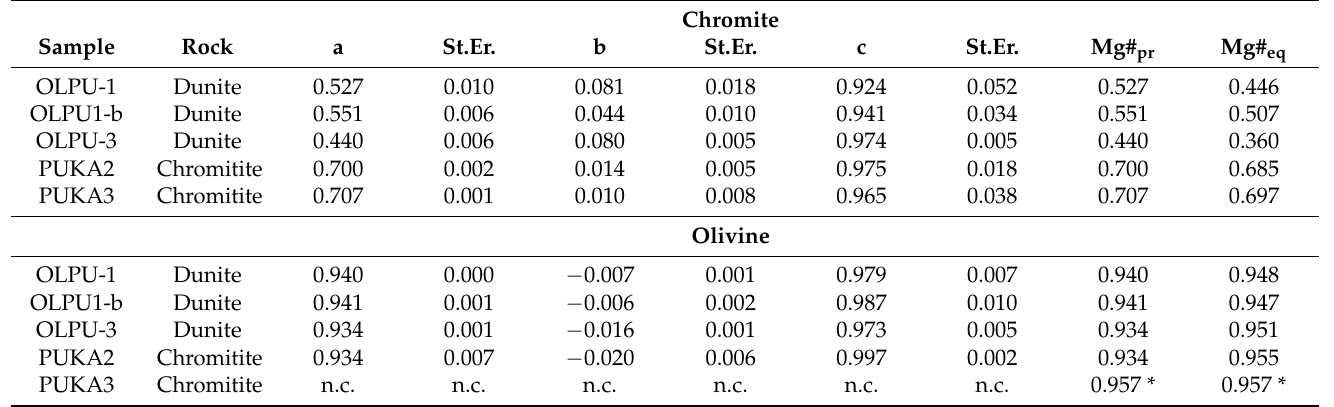
Table 5. Parameters a, b, c and associated standard errors for the calculation of diffusivity curves and primary (pr) and re-equilibrated (eq) Mg# of chromite and olivines in Iballe dunites and chromitites. Chromite